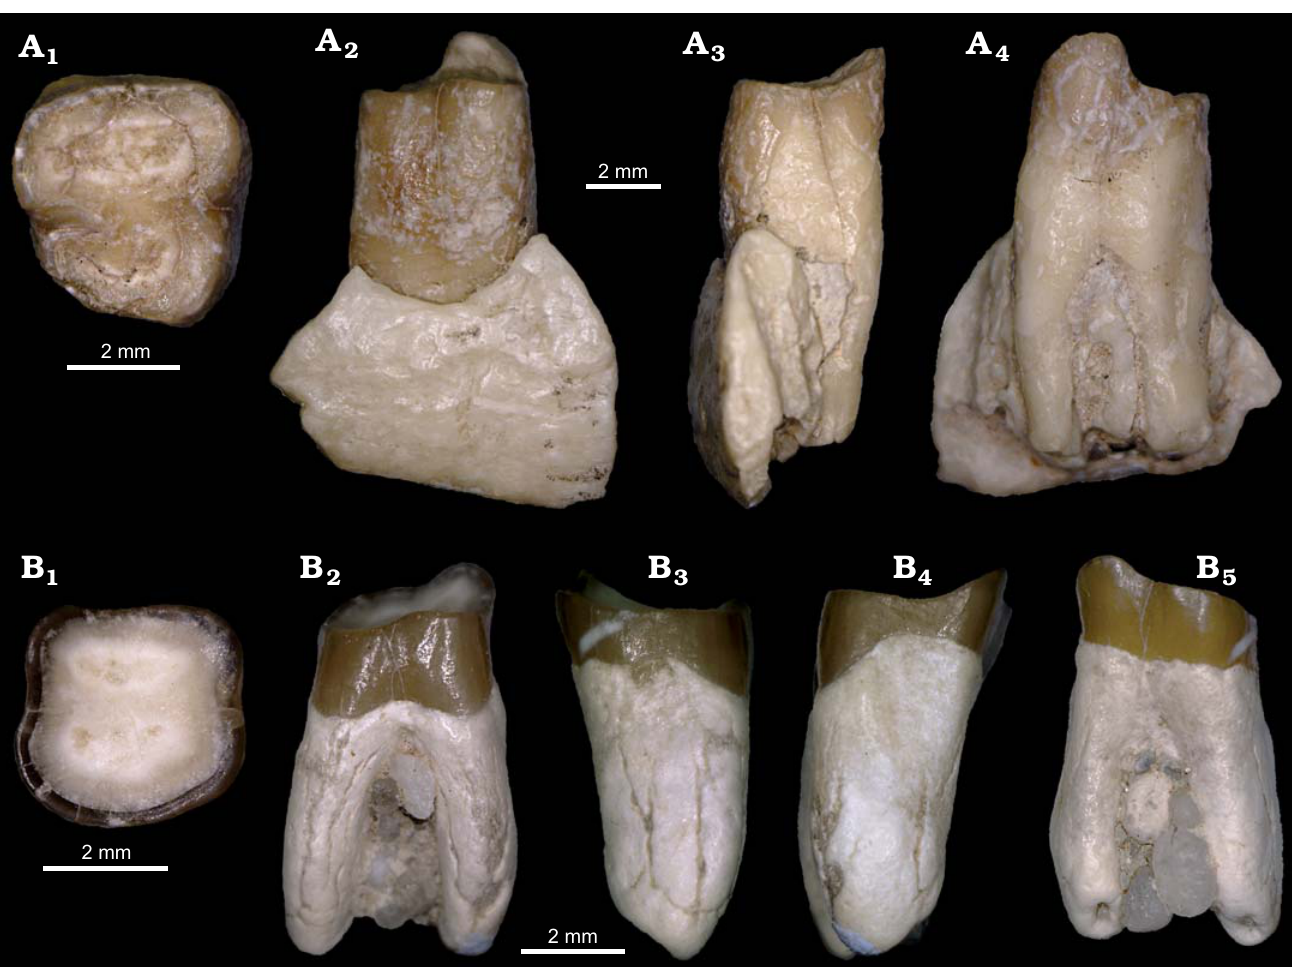
Fig. 2. Anagalid and mimotonid from the Eocene of Wulanhuxiu, Nei Mongol, China. A . Anagalidae gen. et sp. indet., left m1 (IVPP V20825) in occlu- sal (A 1 ), buccal (A 2 ), anterior (A 3 ), and lingual (A 4 ) views. B . Mimolagus aurorae Fostowicz-Frelik, Li, Mao, Meng, and Wang, 2015, right m1 (IVPP V20826) in occlusal (B 1 ), buccal (B 2 ), posterior (B 3 ), anterior (B 4 ), and lingual (B 5 )